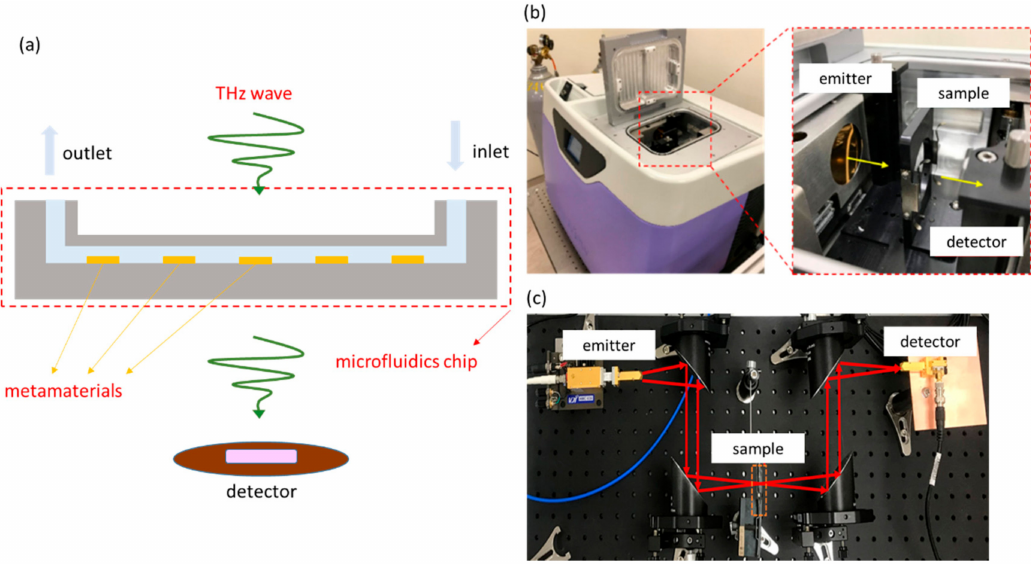
Figure 2. ( a ) Schematic diagram of experimental setup; ( b ) TeraPulse system structure diagram; ( c ) VDI system structure